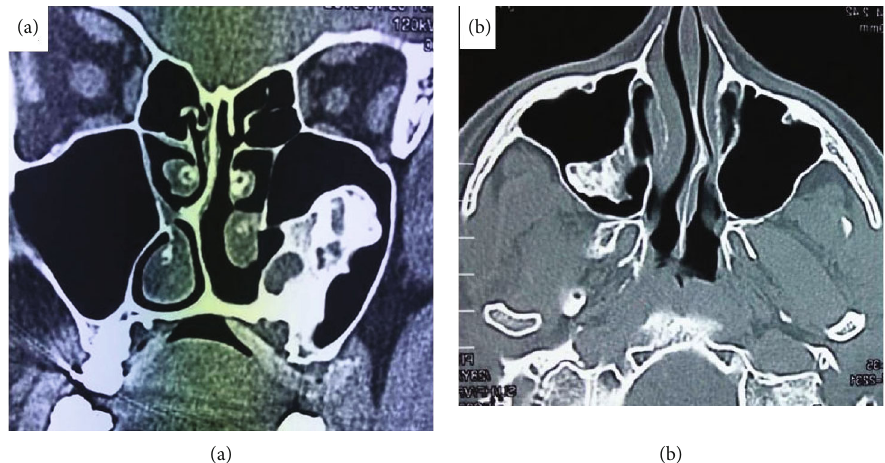
Figure 4: (a, b) CT scan showing a large mass in the left antrum, resting/supported on the fl oor of the antrum. No distinction of the medial antral wall was